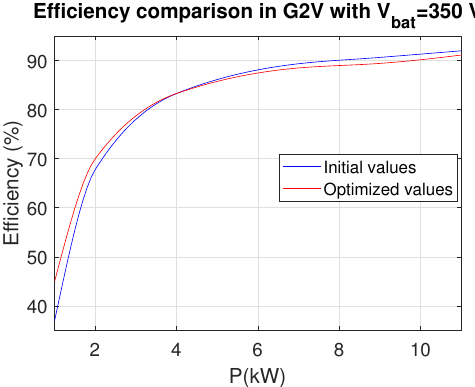
Figure 18. Efficiency comparison in G2V mode with V bat = 350